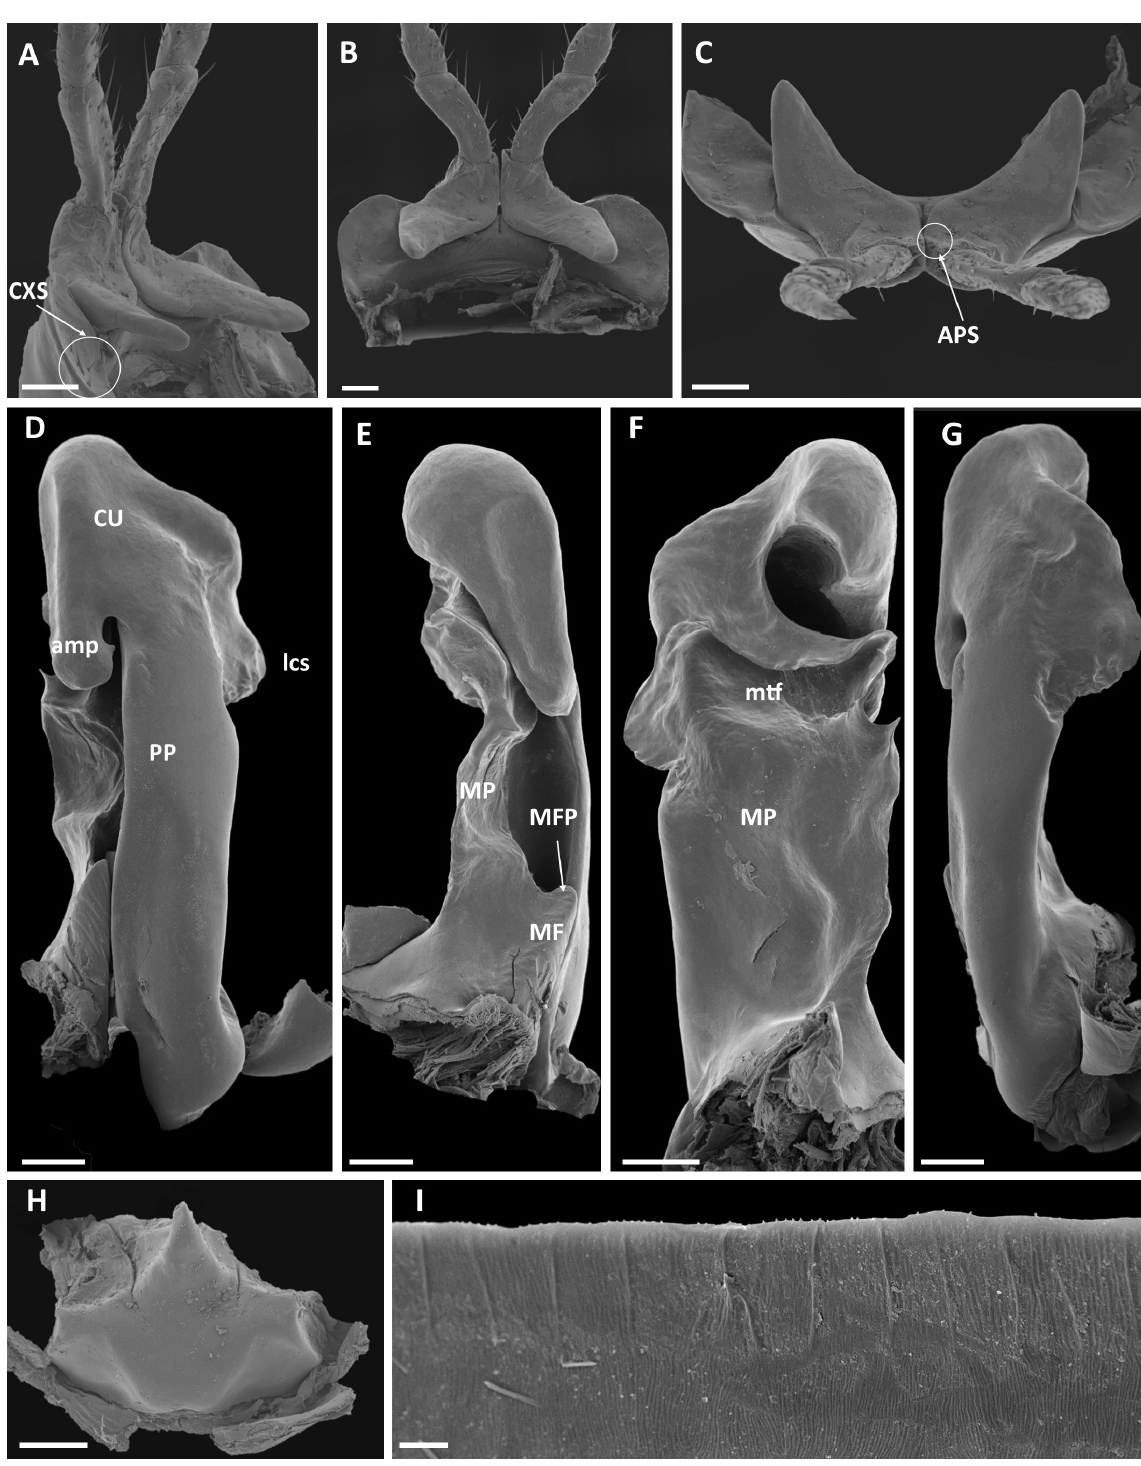
Fig. 26. Chaleponcus nesrineae sp. nov., holotype, ♂ (VMNH110628). A–C . First pair of legs. A. Sublateral view. B. Anterior view. C. Ventral view. D–G . Right gonopod coxa. D. Anterior view. E. Mesal view. F. Posterior view. G. Lateral view. H . Sternum 9. I . Midbody dorsal limbus. Abbreviations: amp = anterior metaplical process; APS = mesapical prefemoral setae; CXS = coxosternal setae; lcs = lateral coxal lobe; MF = metaplical flange; MFP = metaplical flange process; mtf = metaplical transverse fold; MP = metaplica; PP = proplica. Scale bars: A–H = 0.2 mm; I = 0.005